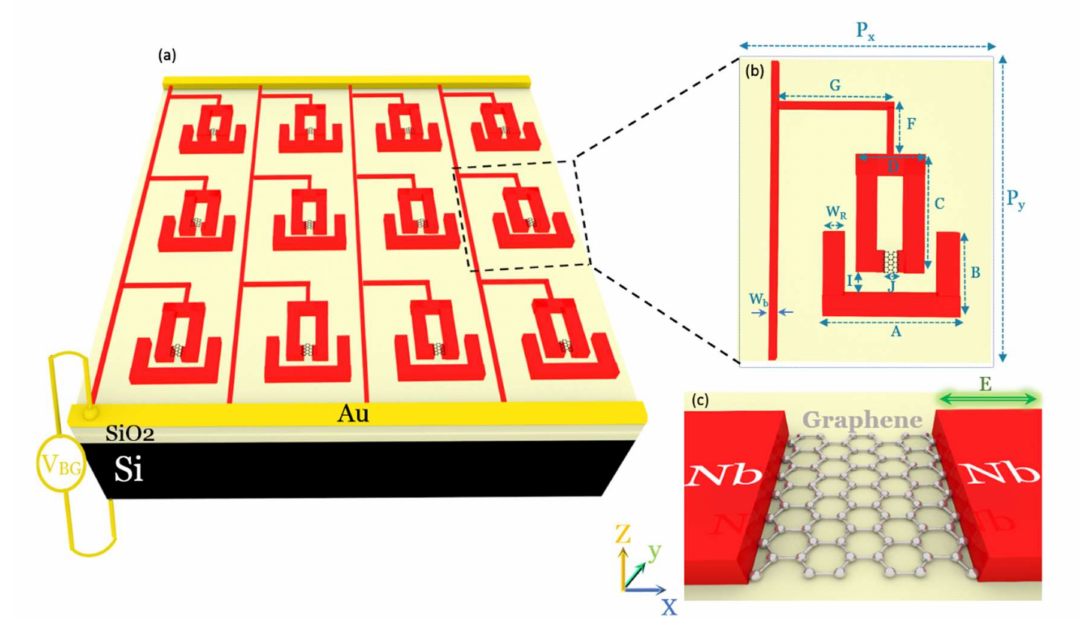
Figure 1. Voltage-controlled hybrid graphene–superconductor THz photonic integrated circuit. ( a ) The hybrid device architecture shows arrays of coupled graphene-Nb SRR integrated with superconducting circuits. Here, Nb, Au, SiO 2 , Si, and graphene are shown in red, yellow, gold, black, and gray, respectively. ( b ) A meta-atom (unit-cell of the device). ( c ) The magnified gap structure of a meta-atom, showing graphene is sandwiched between two Nb fingers in the upper resonator in the superconducting circuit. Polarization of the incident THz wave is shown by a green